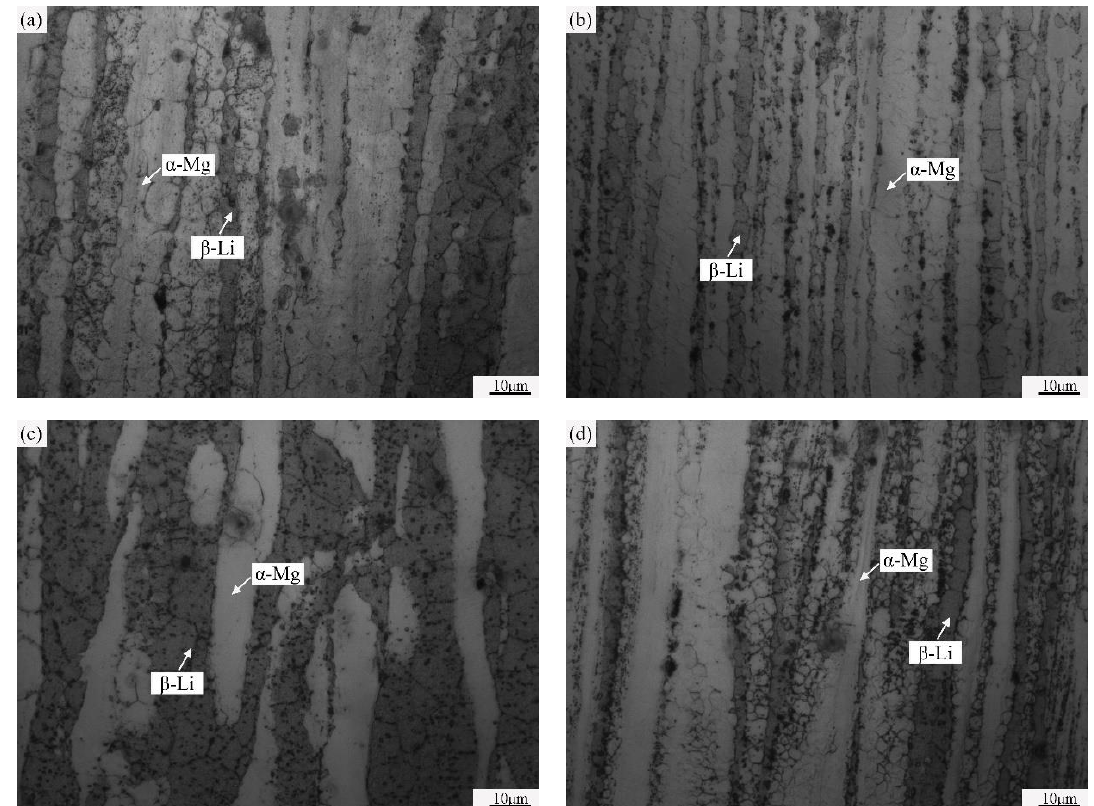
Figure 2. Microstructures of the extruded Mg–7Li–3Al–xCa alloys (parallel to the extrusion direction): ( a ) x = 0 ( b ) x = 0.4 ( c ) x = 0.8 ( d ) x = 1.2.